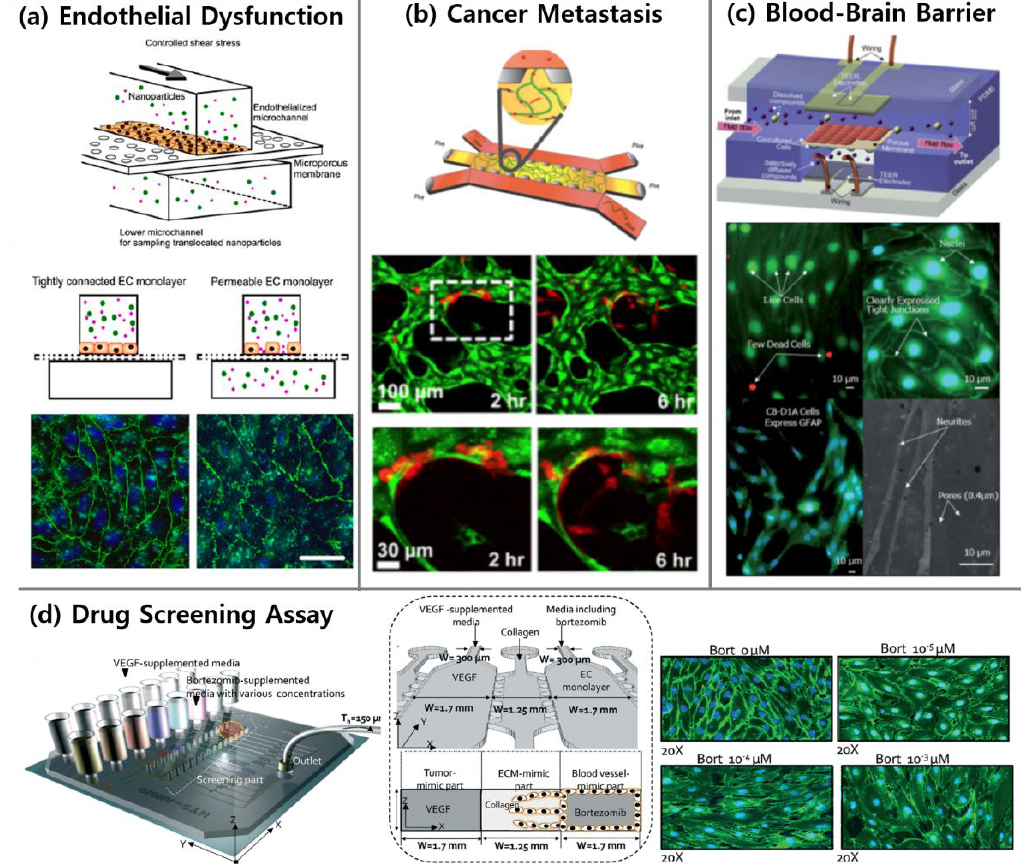
Figure 3. Representative figures of applications using vasculature-on-a-chip. ( a ) Increased permeability of inflamed endothelium was demonstrated with translocation of nanoparticles over an EC monolayer and immunostaining of VE-cadherin (green) and nuclei (blue) [98]. Scale bars 20 µm. ( b ) The bone microenvironment was replicated to investigate extravasation of breast cancer cells (red) from microvasculature (green) [23]. ( c ) Microfluidic model of the blood-brain barrier (µBBB) was characterized, and its validity was demonstrated [121]. ( d ) HUVECs morphology was investigated quantitatively depending on anti-angiogenic drug concentrations to find optimal effective concentration which minimizes both the number of migrated HUVECs and their morphological changes [24]. Reproduced with